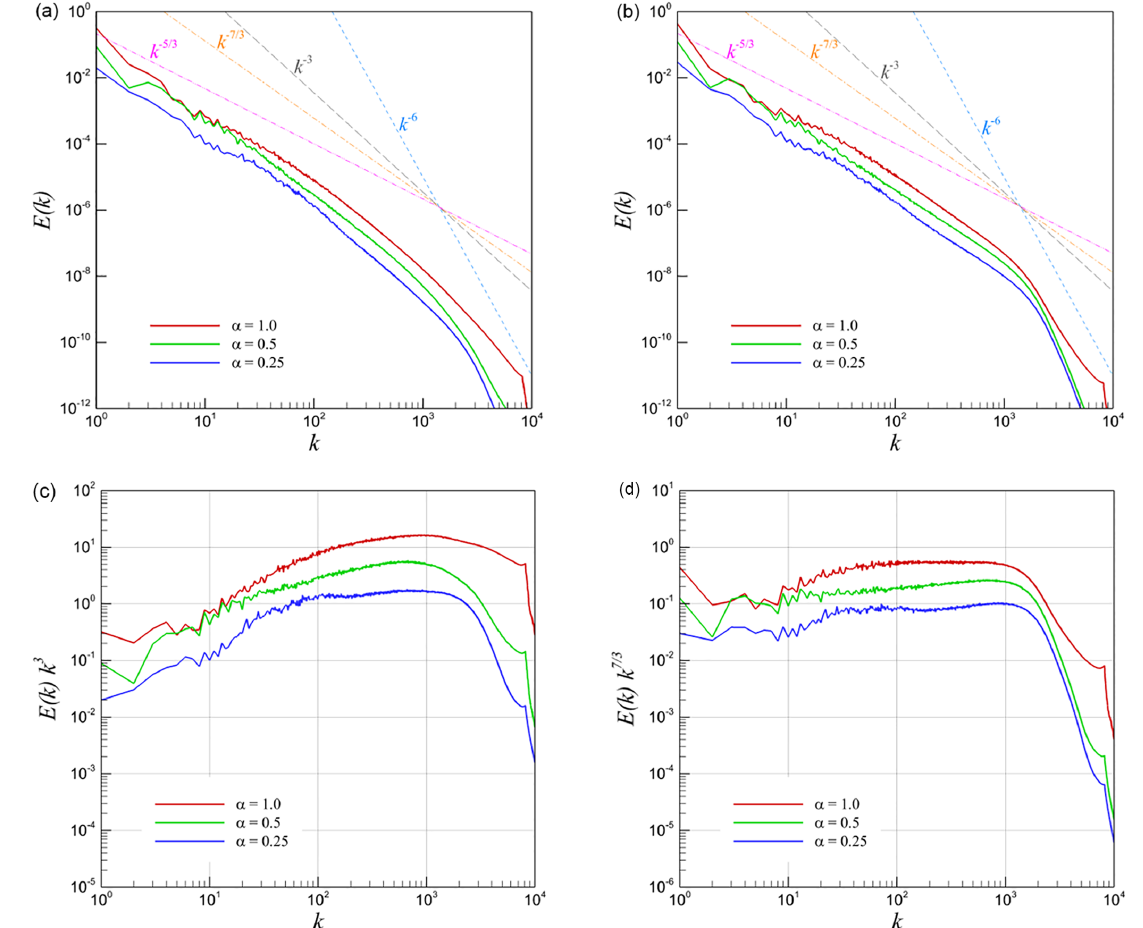
Figure 12. Angle-averaged energy spectra for 2-D KHI turbulence. (a) Spectra built on using the velocity u , (b) spectra built on using the √ ρ u , (c) compensated spectra built on using the velocity u , and (d) spectra built on using the density-weighted density-weighted velocity ω = √ ρ u . velocity ω =